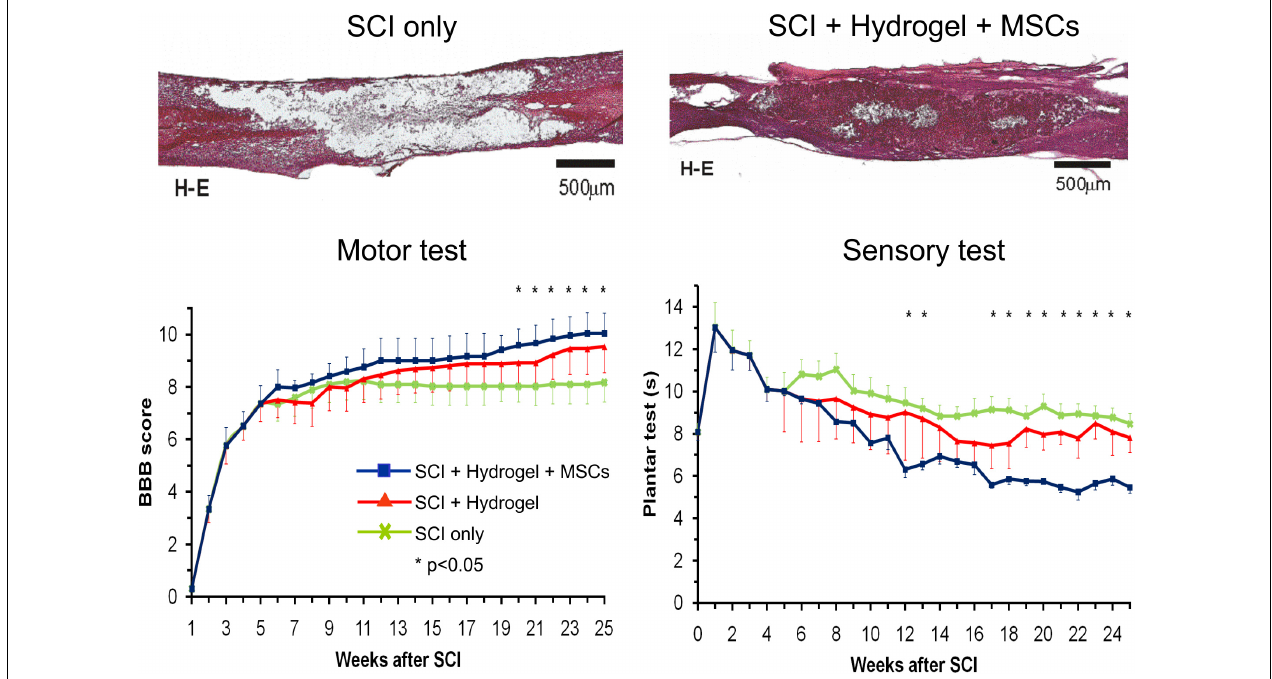
FIGURE 3 | Hematoxylin–eosin staining of a rat spinal cord with acute balloon-induced spinal cord compression lesion. Spinal cord injury (SCI) only: longitudinal section of the spinal cord with a cavity in the control animal at 6 months after SCI. SCI + hydrogel + mesenchymal stem cells (MSCs): spinal cord at 6 months after a lesion with MSC-seeded HPMA-arginine–glycine–aspartic acid hydrogel implanted at 5 weeks after SCI. Motor test and sensory test: A comparison of motor test (Basso, Beattie, and Bresnahan score) and sensory test (plantar test) in 1–25 weeks after SCI in rats with SCI only, SCI and hydrogel implantation, and SCI with implantation of hydrogel seeded with bone marrow mesenchymal stem cells. Modified from Hejcl et al.